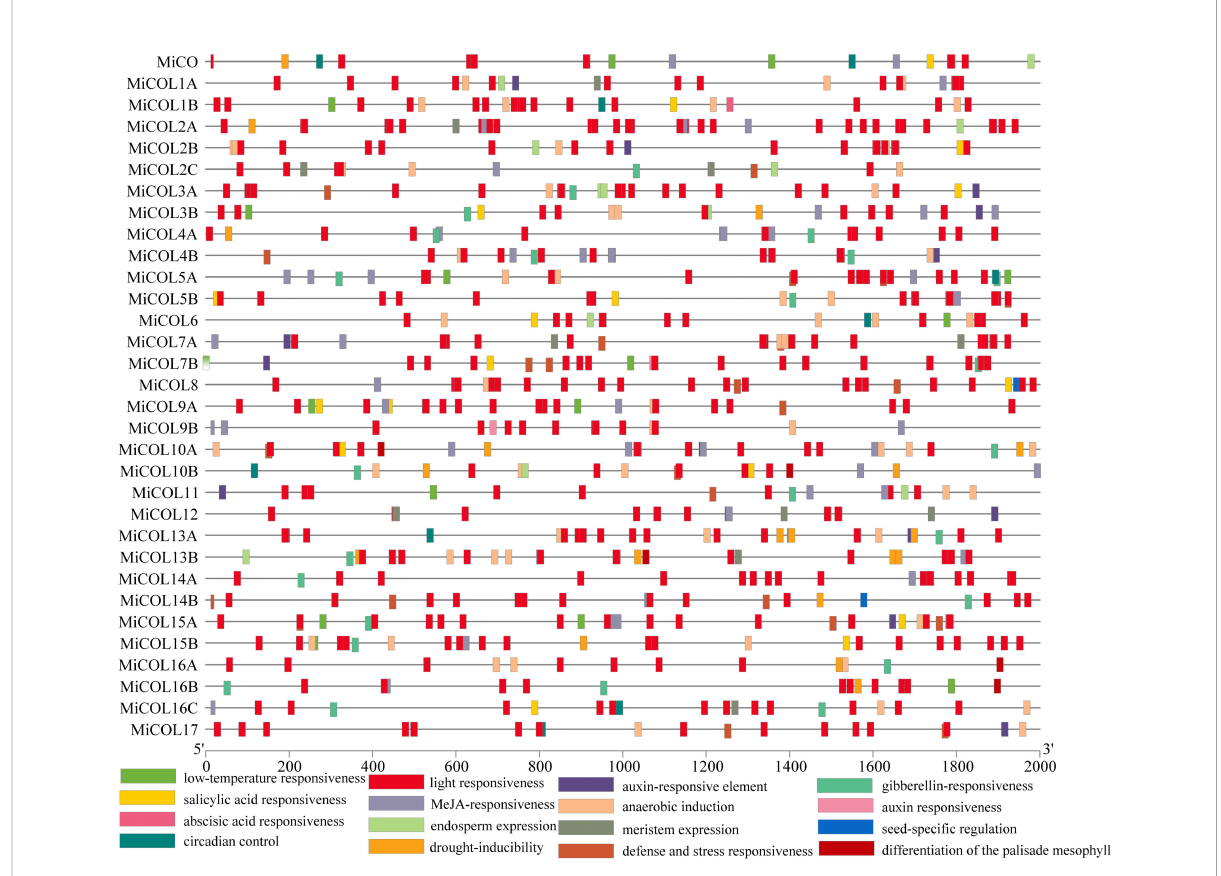
FIGURE 3 Analysis of cis-elements within the promoters of MiCOL gene family